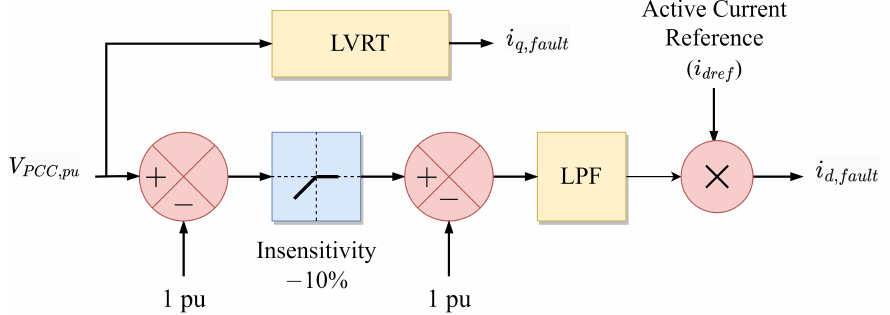
Figure 9. Control configuration for a voltage-dependent active current deduction [103,104].